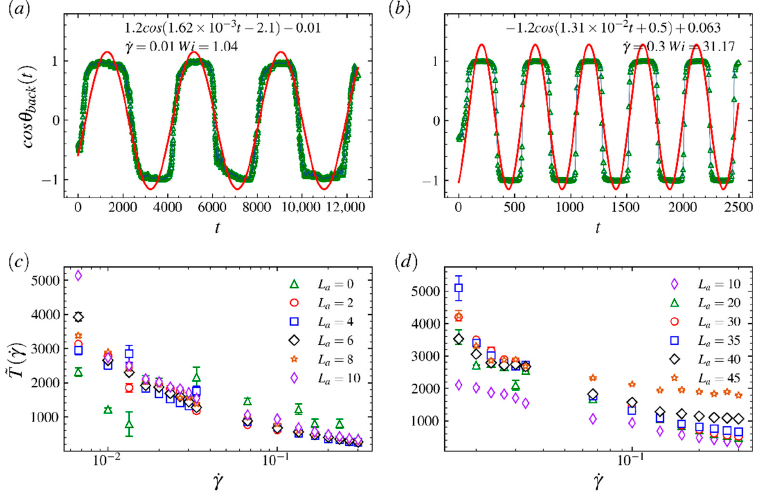
Figure 7. The temporal changes of the cosine value of the angle that the end-to-end vector of the backbone makes with respect to the flow direction at ( a ) Wi = 1.04 and ( b ) 31.17, where the backbone and arm length are L b = 20 and L a = 20, respectively. ( c , d ) The period as function of Weissenberg number Wi for various arm lengths, where the arm length L a = 0 represents the bare backbone.